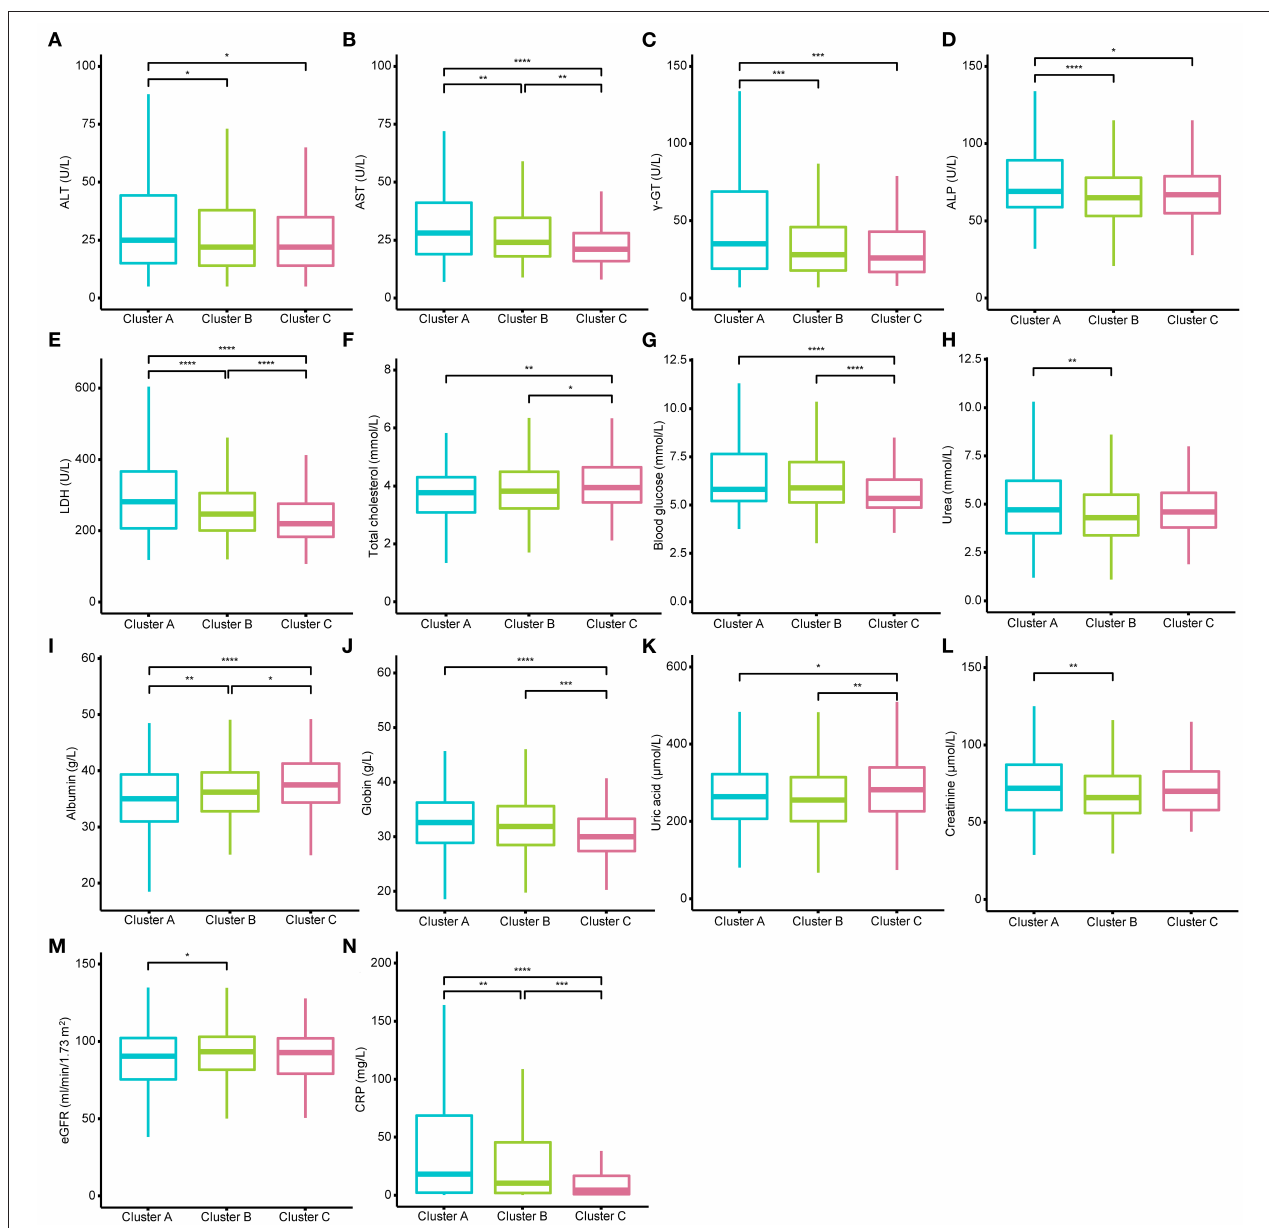
FIGURE 3 | Different levels of blood biochemistry tests among the three clusters. (A–N) show the different levels of alanine transaminase (ALT), aspartate transaminase (AST), gamma-glutamyl transferase ( γ -GT), alkaline phosphatase (ALP), lactic dehydrogenase (LDH), total cholesterol, blood glucose, urea, albumin, globin, uric acid, creatinine, estimated glomerular filtration rate (eGFR), and C-reactive protein (CRP) among the three clusters. AST, LDH, CRP, and albumin could well-distinguish the three clusters. The Kruskal–Wallis tests with Dunn’s post-test was performed, and the p- value were adjusted by the